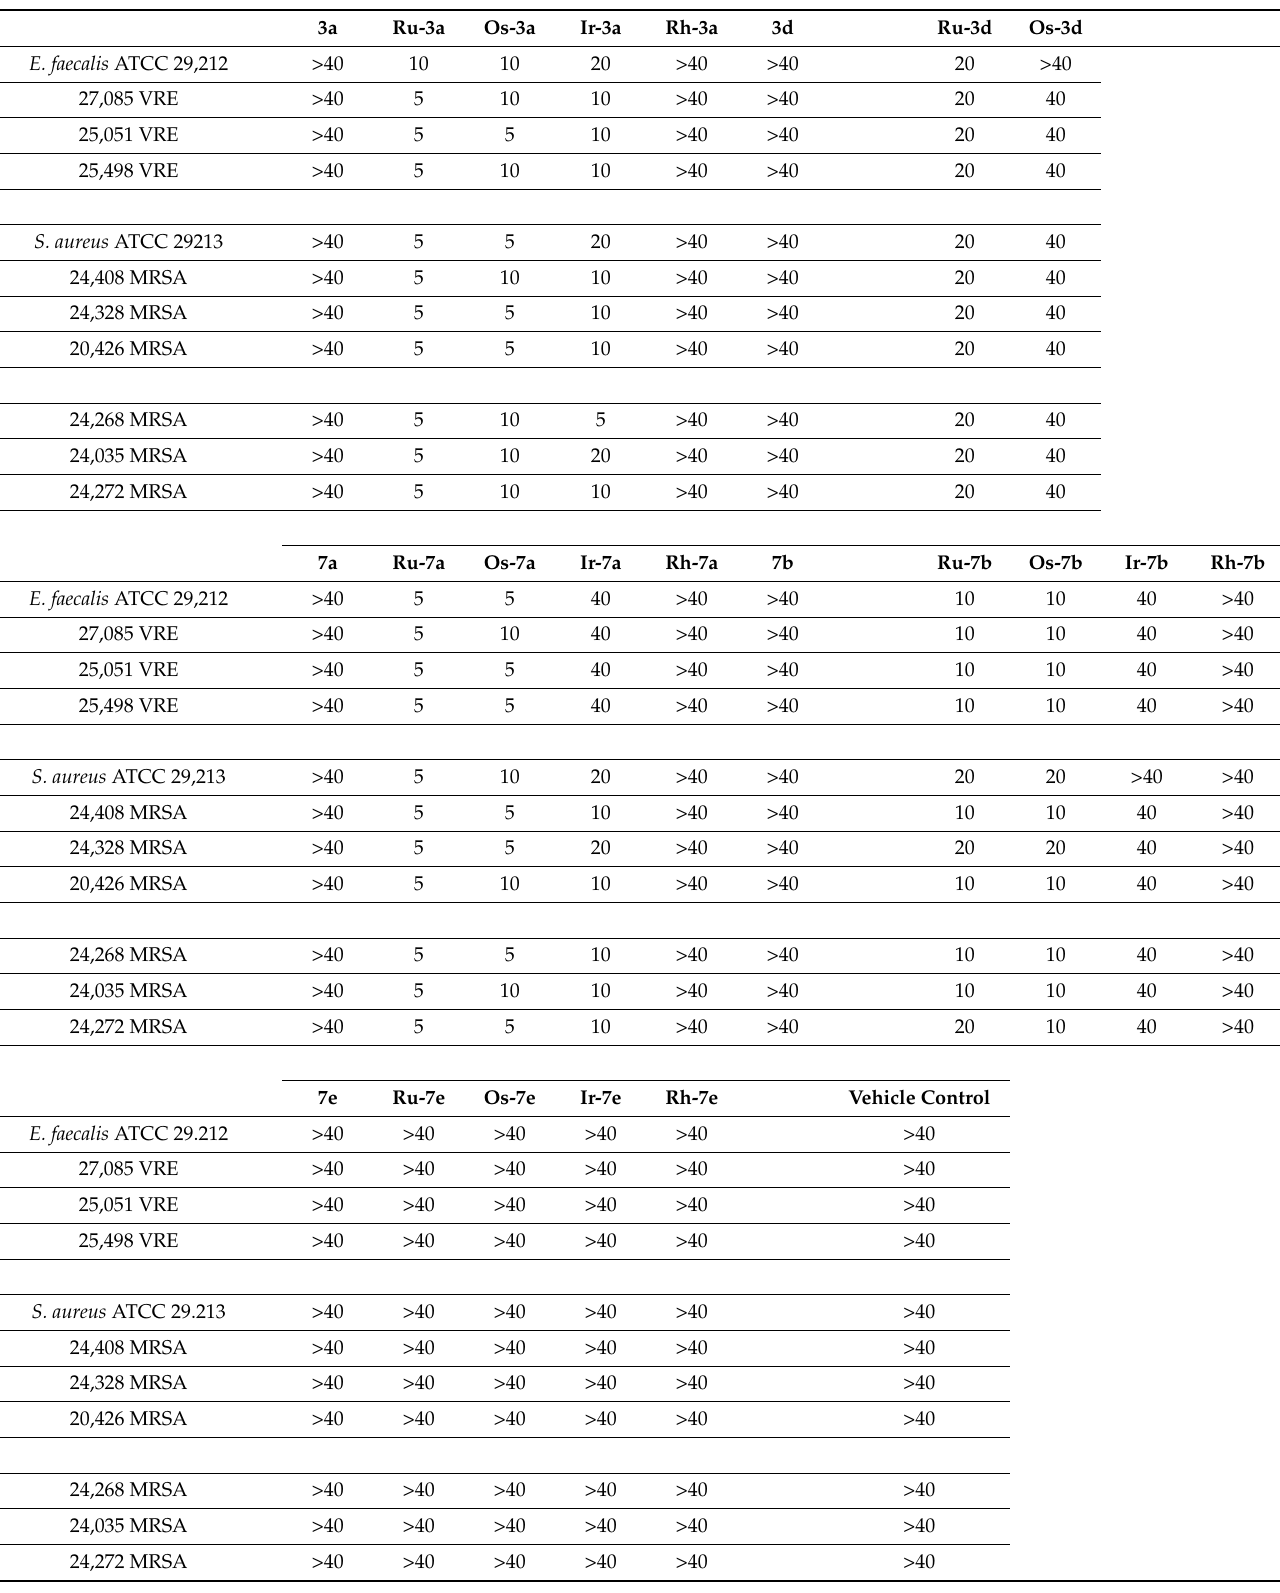
Table 8. The MIC values ( µ M) of a subset of ligands and